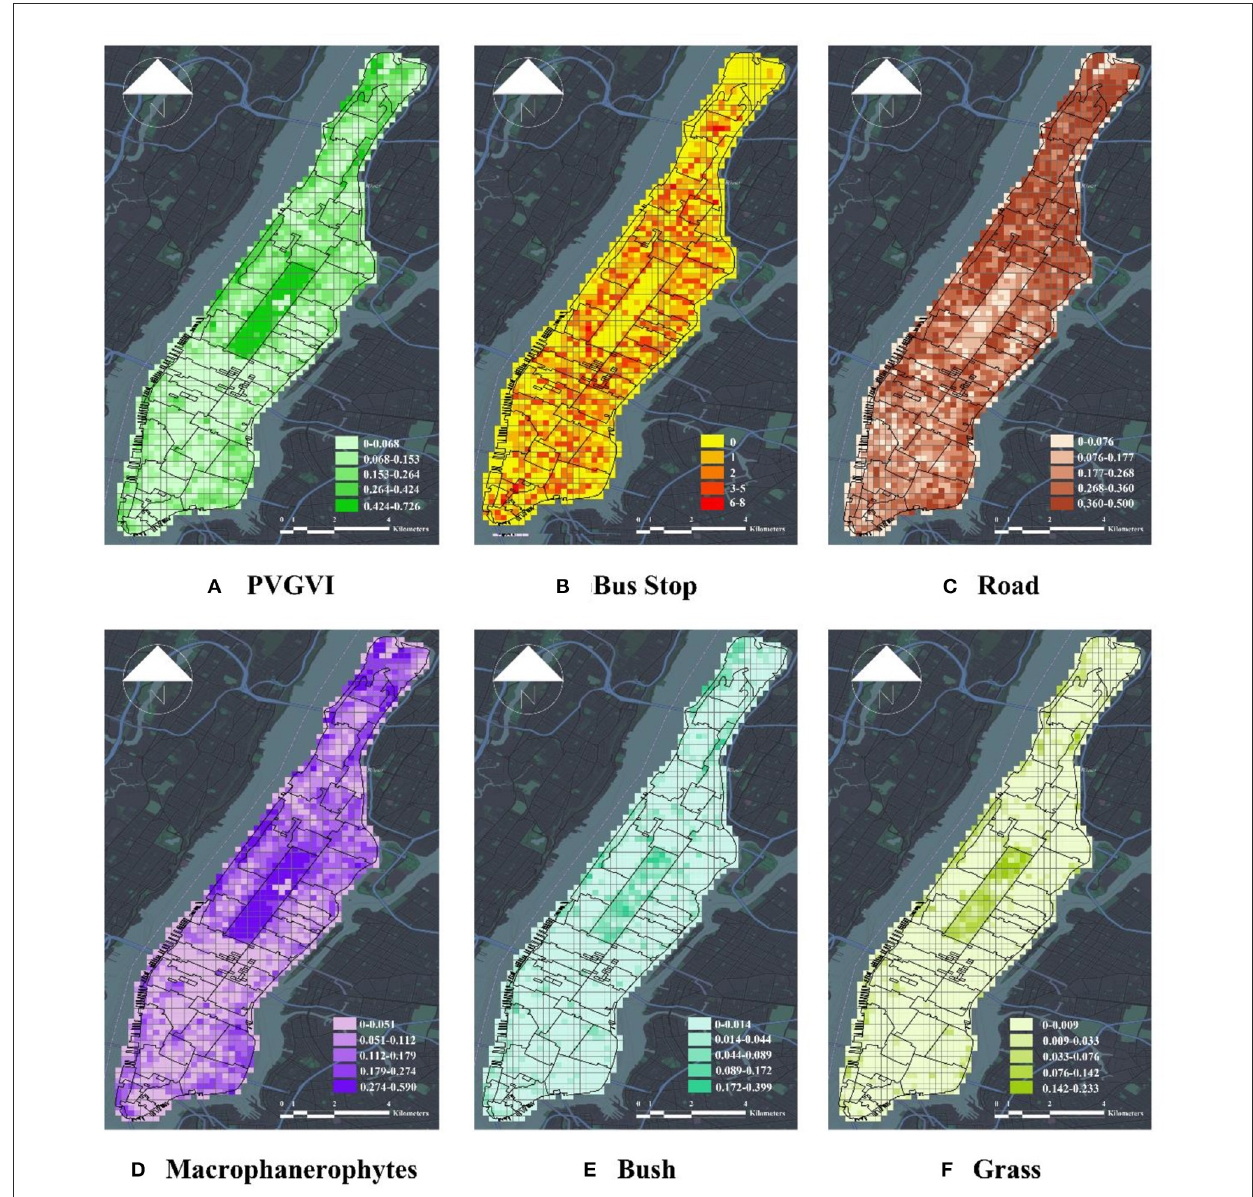
FIGURE5 Visualization of micro-scale factors of urban built environment. (A) PVGVI, (B) bus stop, (C) road, (D) macrophanerophytes, (E) bush, and (F) grass.